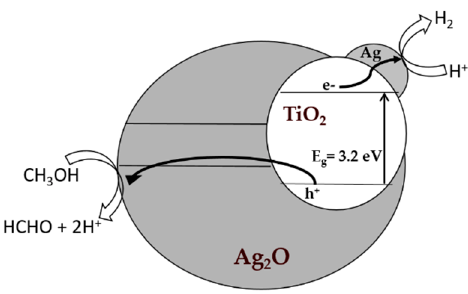
Figure 10. Mechanism of hydrogen evolution from aqueous methanol under UV/vis illumination.